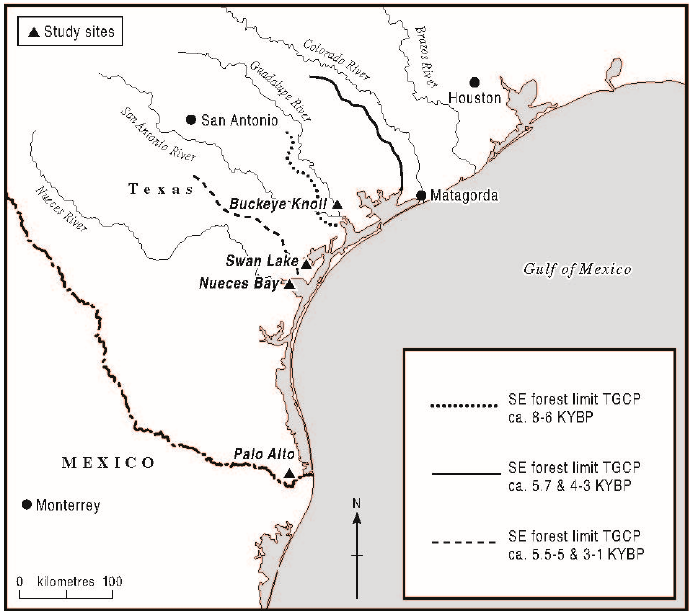
Figure 8. Oscillations of the Southeastern United States Forest Limit (oak–pine–hickory mixtures) during the Holocene, as reconstructed by multi-site pollen data. Estimates as to the position of the forest–prairie ecotone were made according to 20% AP levels not including Pinus at examined pollen sites. See supplemental data for the Palo Alto pollen diagram for the Lower Rio Grande valley (please see the Palo Alto pollen diagram supplemental file).